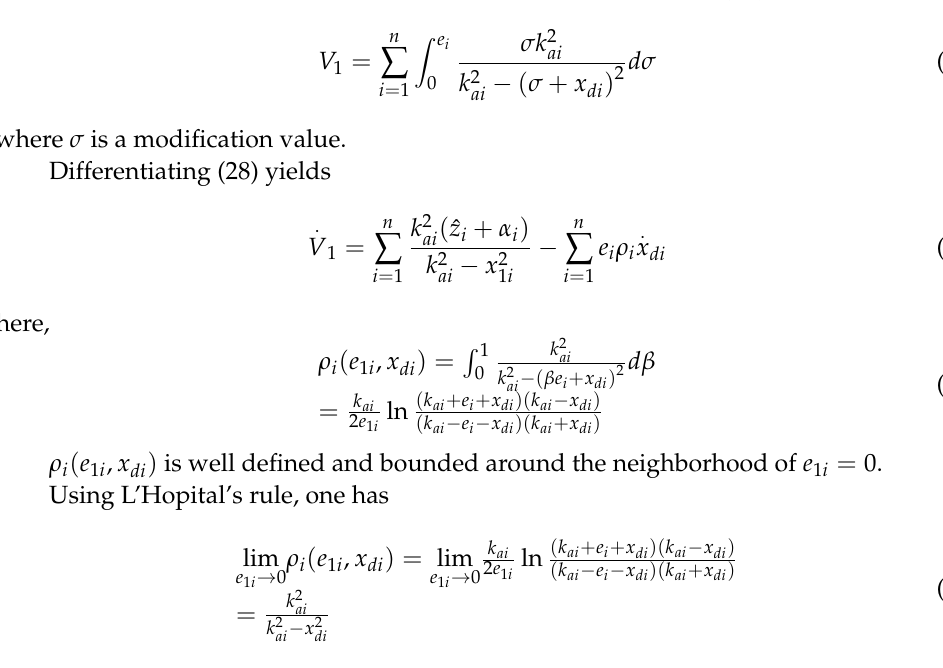
Table 2. D-H Parameters of 6-DOF JAKA robot. Link i